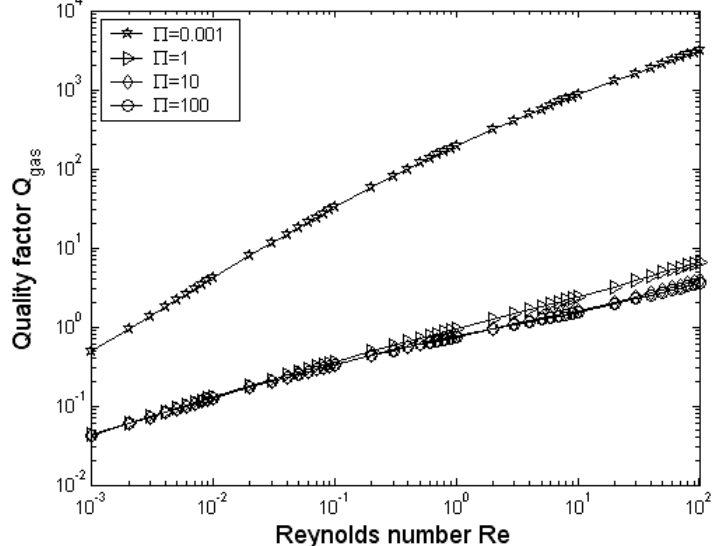
Fig. 5. Quality factor Q gas as a function of the Reynolds number R e for the fundamental mode at different natural scaling parameter Π .